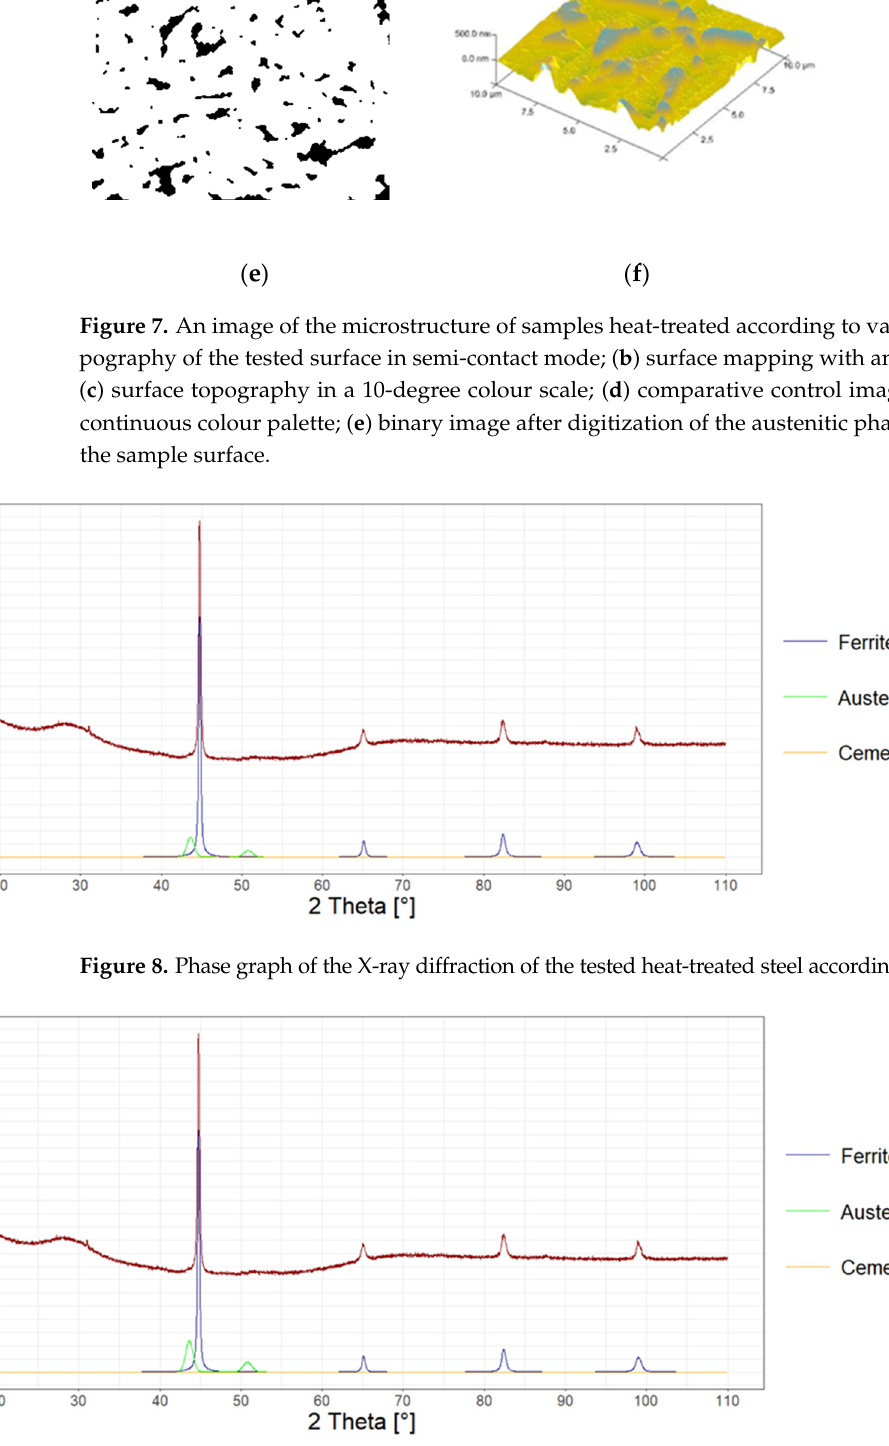
Figure 7. An image of the microstructure of samples heat ‐ treated according to variant no. 1: ( a ) topography of the tested surface in semi ‐ contact mode; ( b ) surface mapping with amplitude con ‐ trast; ( c ) surface topography in a 10 ‐ degree colour scale; ( d ) comparative control image with a lim ‐ ited continuous colour palette; ( e ) binary image after digitization of the austenitic phase; ( f ) 3D view of the sample surface.